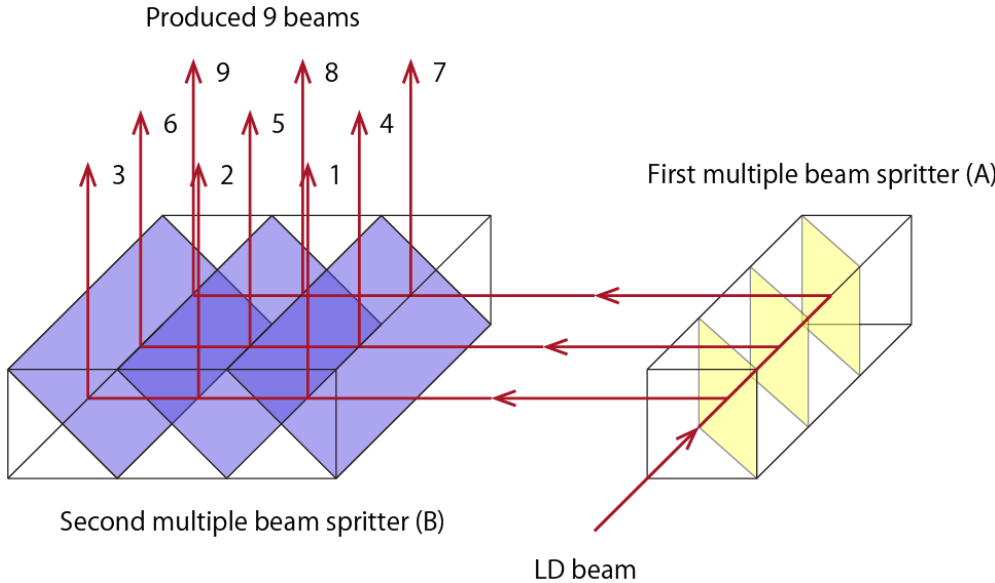
Figure 2. Perspective diagram of direction of radiation of the laser